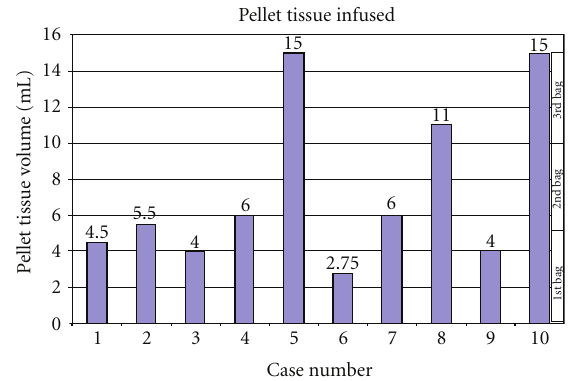
Figure 6: Amount of tissue infused. After digestion and purification (when applied), the pancreatic cell pellet (comprised between 2.75 and 15 mL) is suspended in medium containing human serum albumin and bagged for infusion. Each bag contains a maximum of 5mL of pellet tissue.